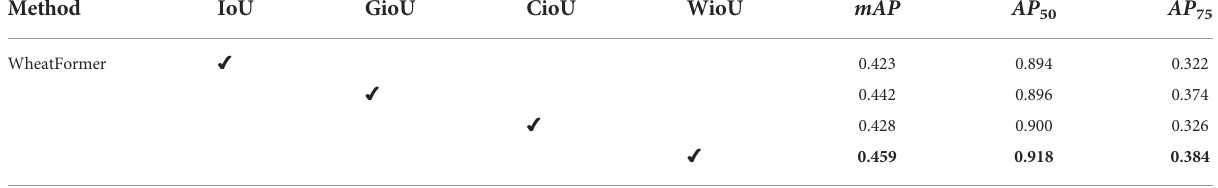
TABLE 5 Results of WheatFormer with different IoU loss functions.